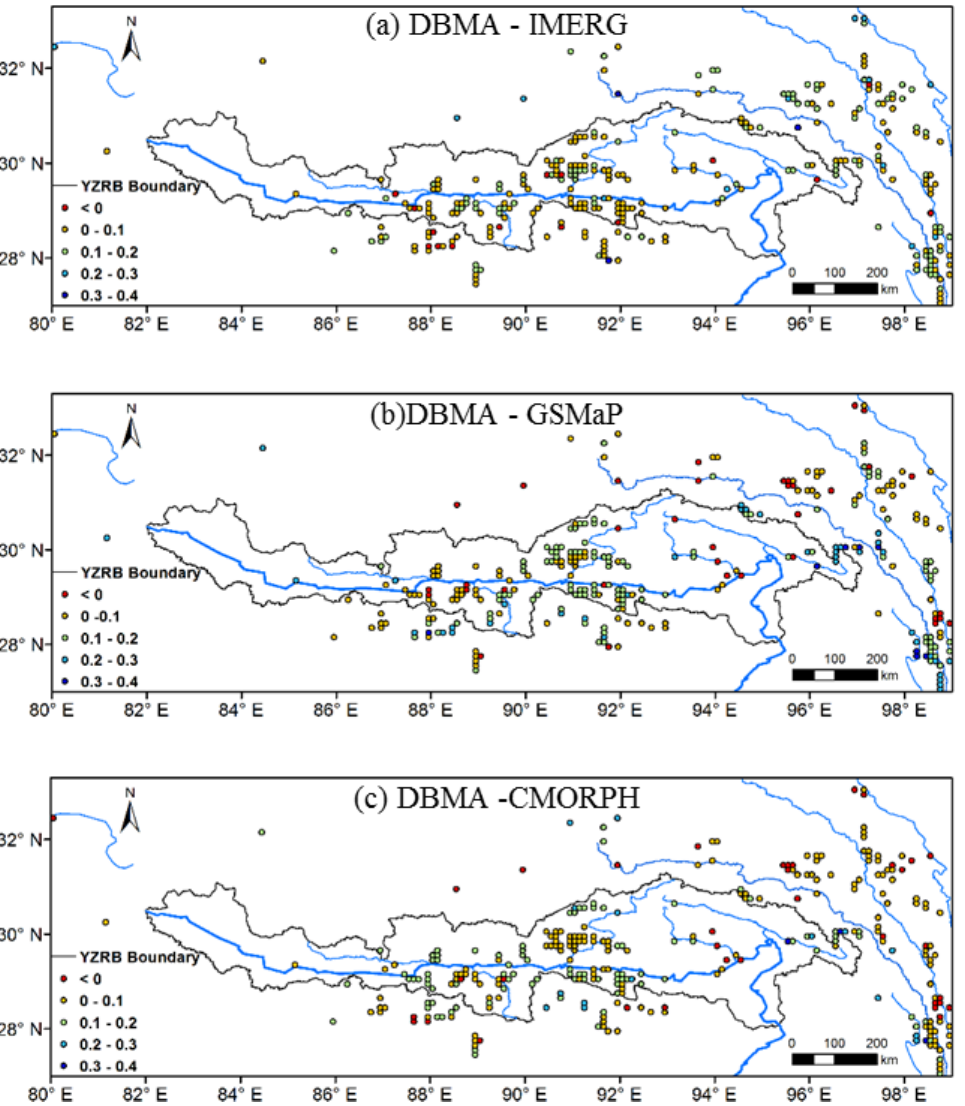
Figure 6. Spatial distributions of CC difference between (a) DBMA and IMERG, (b) DBMA and GSMaP, and (c) DBMA and CMORPH.